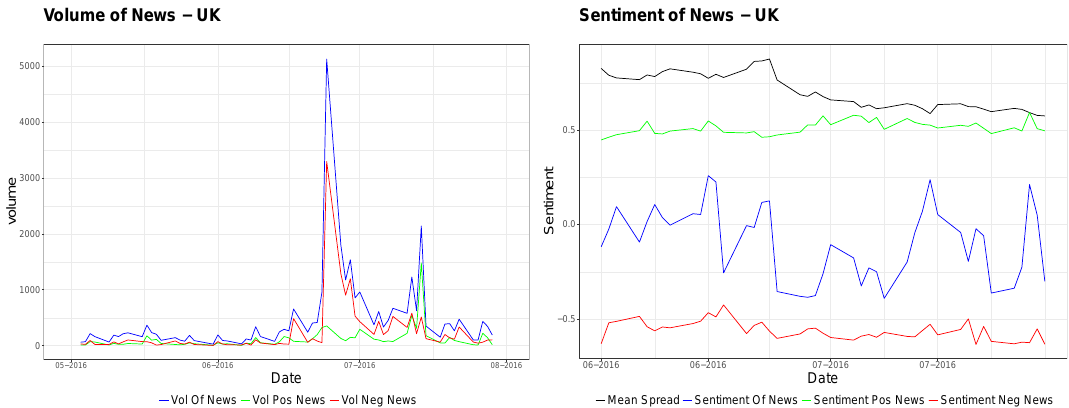
Figure 2. Daily news volume and sentiment from entity “UK” between May and July